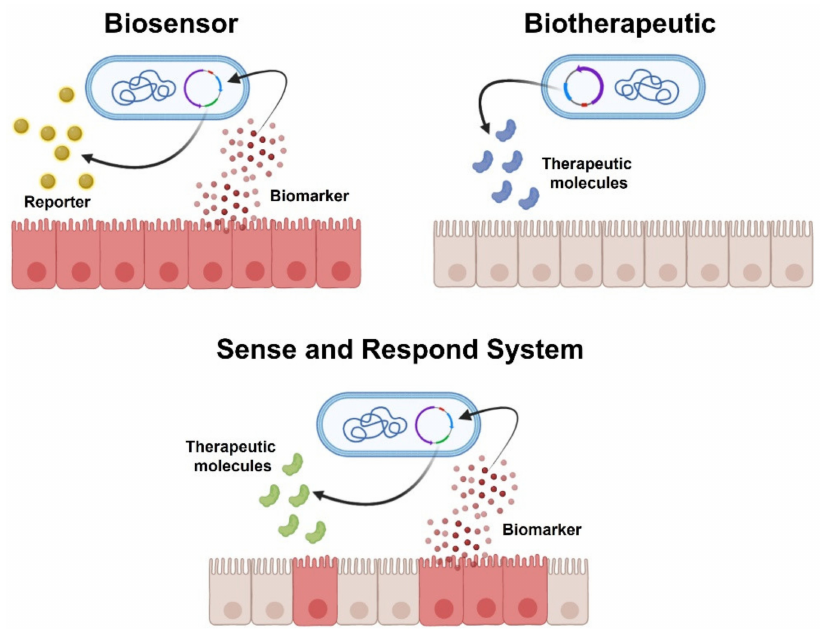
Figure 2. Main approaches in probiotics engineering exploited in IBD. Biosensors can induce the expression of a reporter (usually a fluorescent marker) upon detecting specific biomarkers of inflam- mation. Biotherapeutics are able to produce at the mucosal surface a therapeutic molecule either constitutively or following the activation of an exogenous substrate (inducible systems). Sense and respond systems incorporate the technology of biosensors by responding to specific biomarkers of inflammation with the production of a therapeutic